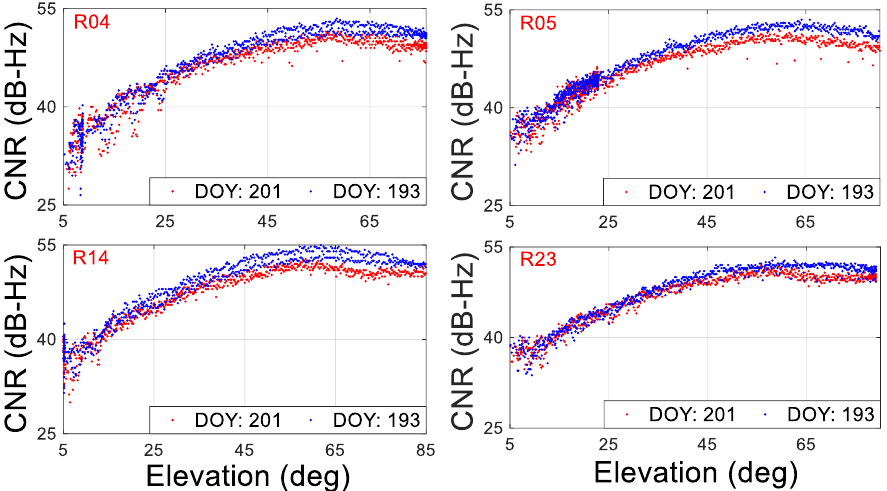
Figure 12. CNR of GLONASS satellite L1 frequency comparison between under the flood and the normal weather. The blue dots denote the CNR collected on DOY:193 (no flood), and the red dots denote the CNR collected on DOY:201 (with flood).